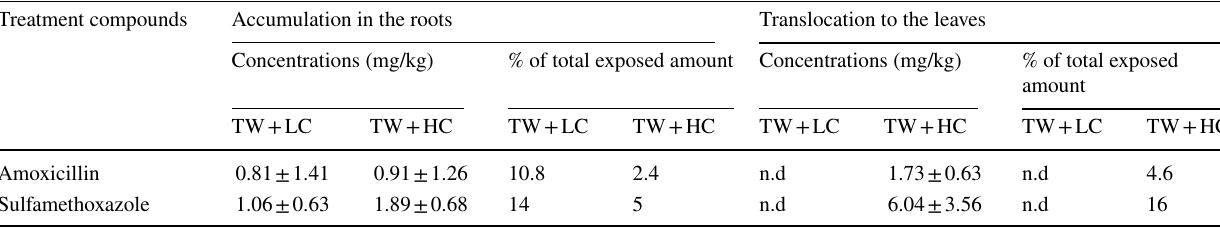
The results were calculated for three replicate samples and presented as mean values, groundwater (GW) and treated wastewater (TWW) treat- ments were free from the four pharmaceuticals. Ibuprofen and trimethoprim were not detected in the spiked treatments. TW + LC: treated waste- water with low concentration of mixed pharmaceuticals and TW + HC: treated wastewater with high concentration of mixed pharmaceuticals, n.d not